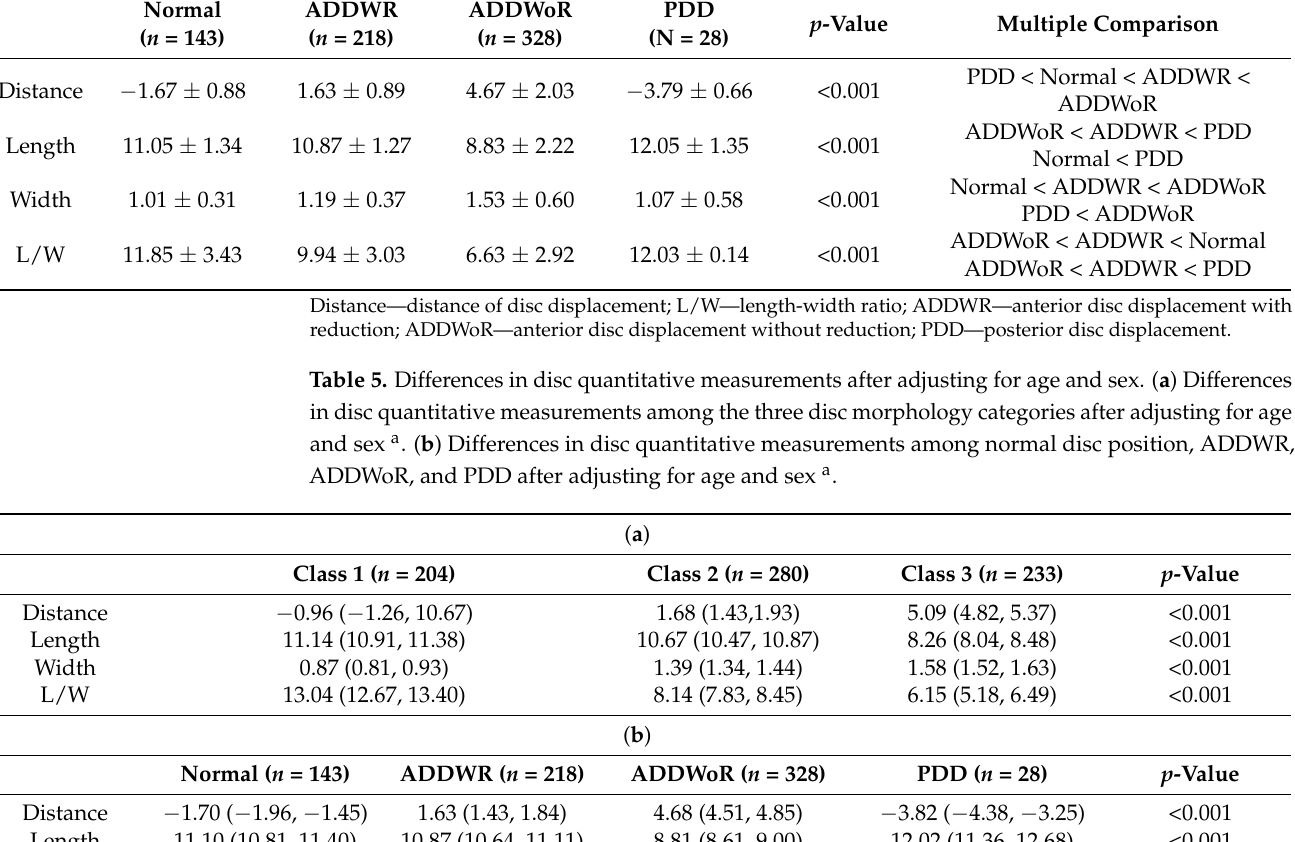
Table 4. Differences in disc quantitative measurements among normal disc position, ADDWR, ADDWoR, and PDD.